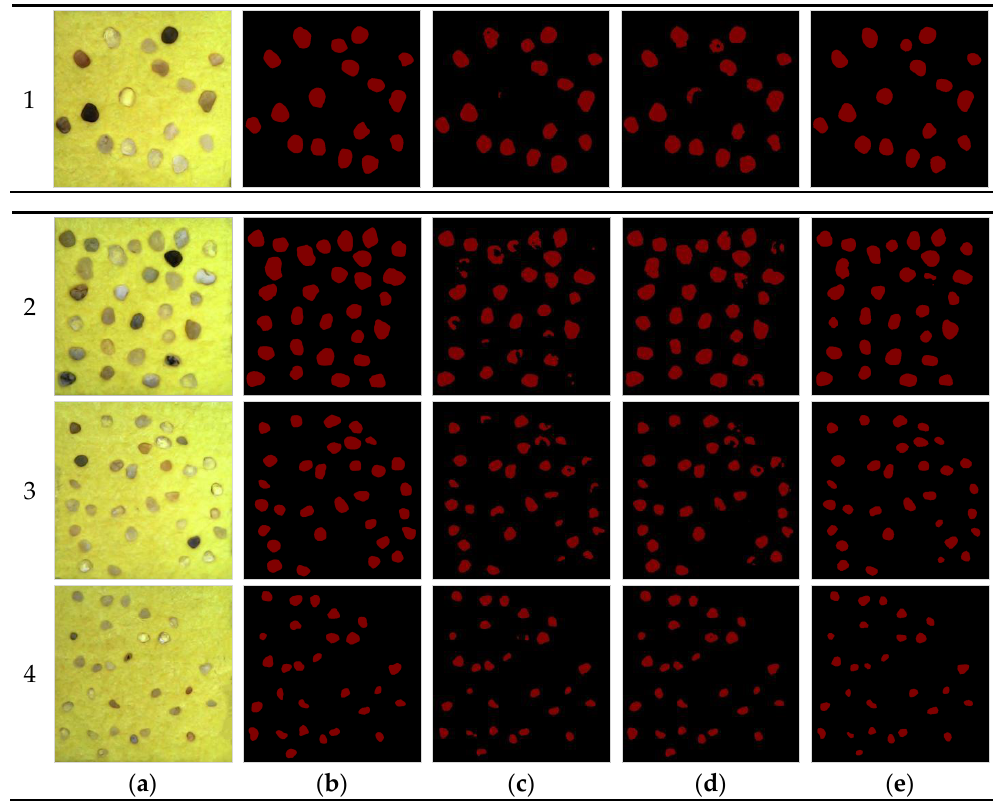
Figure 10. The segmentation effects of three deep learning networks on four particle sizes of sand (row 1 – 4 −40 + 70, −70 + 100, −100 + 140, −140 + 400 meshes): ( a ) original image; ( b ) ground truth; ( c ) Deeplab-Xception; ( d ) UNet-Mobile;( e ) FCN-ResNet50.